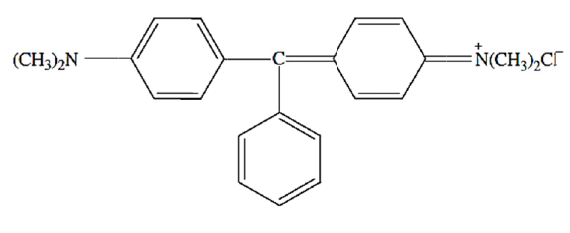
Fig. 1. Molecular structure of